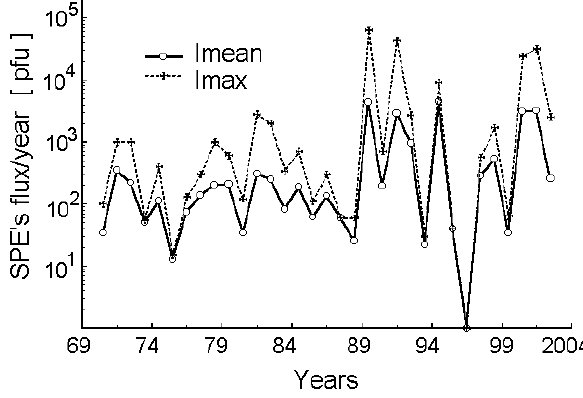
Fig. 3. Time distribution of yearly averaged and maximum intensity of the SPEs flux from 1970 to